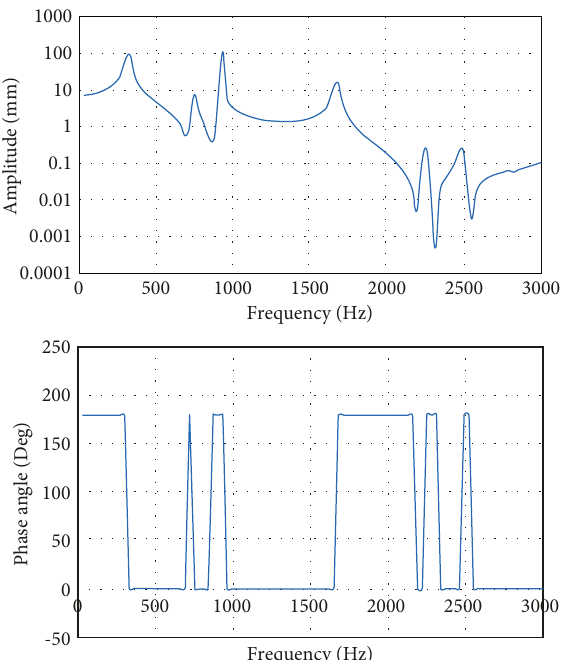
Figure 16: Frequency response diagram of carbon composite crankshaft.